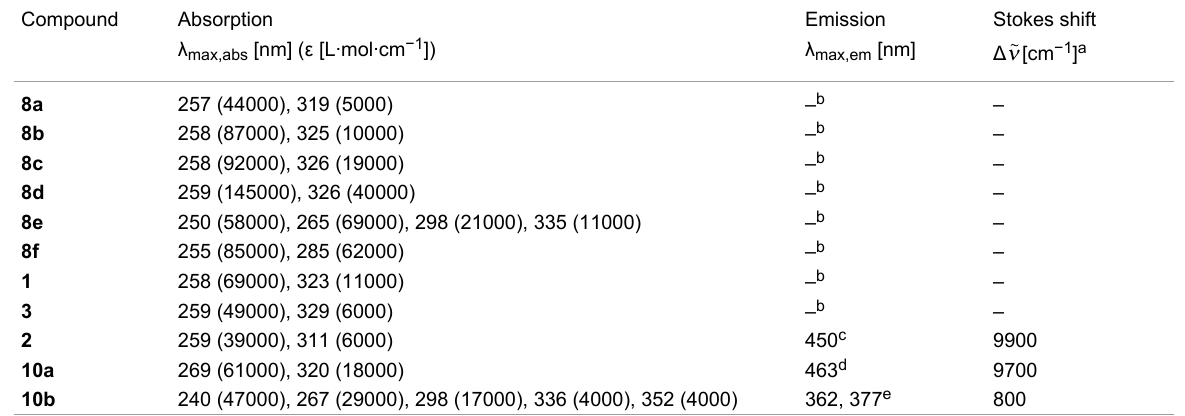
Table 2: Absorption and emission characteristics of the dyads 8 , 1 , and the reference systems 2 , 3 , and 10 (recorded in CH 2 Cl 2 , c = 1.4–3.1 ∙ 10 − 5 mol·L − 1 , T = 298 K). Compound